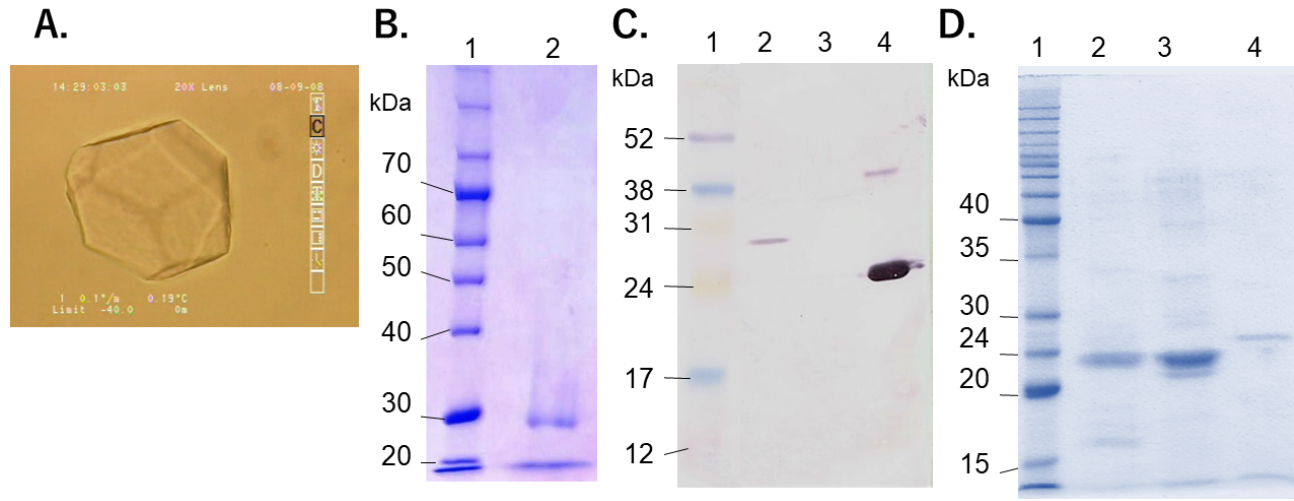
Figure 6. IBPs in both the frozen colony and culture of G. antarctica strain S4B. Development of ice crystal in the extracellular fraction from frost-columnar colony ( A ). SDS-PAGE of the extracellular fractions from frost-columnar colony with Coomassie Brilliant Blue staining ( B ) Immunoblotting of the extracellular fractions from frost-columnar colony and SDS-PAGE of culture broths of G. antarctica strain S4B and other basidiomycetes ( C ). Molecular marker (lane 1), the extracellular fractions from frost-columnar colonies (lane B2 , C2 and D4 ), culture broth of Pichia pastoris without Tis AFP gene (negative control; lane B3 ), culture broth of P. pastoris transformed Tis AFP6 gene [43] (positive control; lane B4 ), culture broth of Coprinus psychromorbidus (lane D2 ), and culture broth of T. ishikariensis BRB (lane D3 ). Forty μ L of the extracellular fractions and culture broths were loaded on lanes 2–4, respectively.